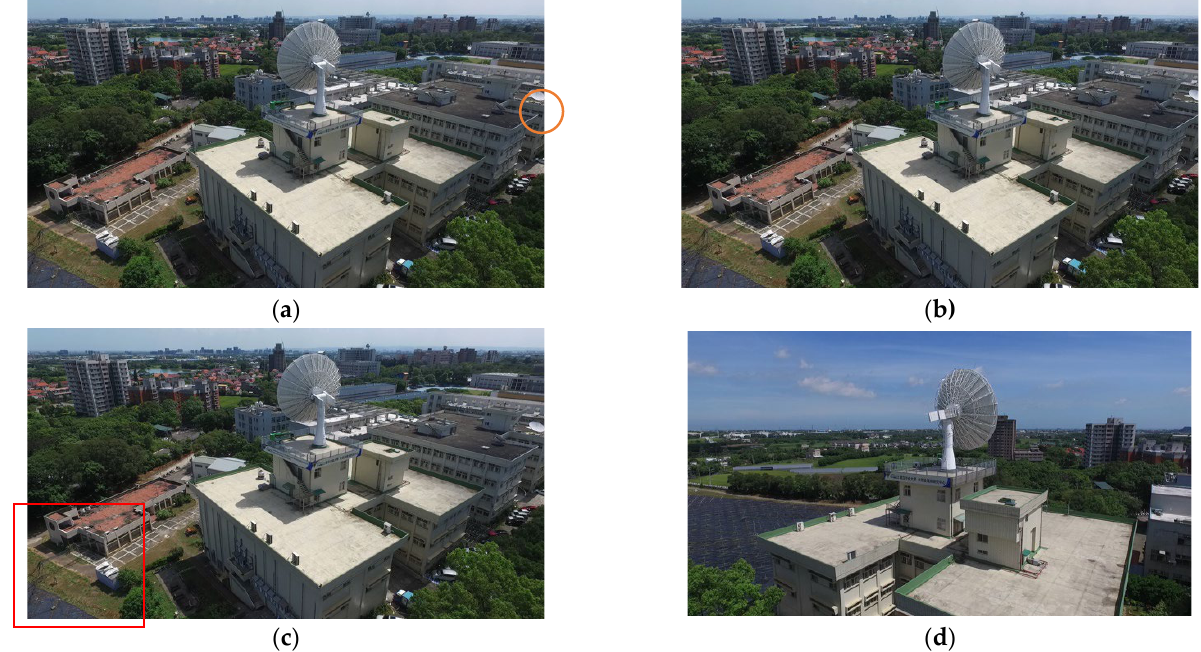
Figure 4. Satellite Receiver Dataset with UAV from CSRSR. The image pair ( a ) and ( b ) with a small shift marked by the orange circle. The image pair ( c ) and ( d ) with an increased motion marked with a red square.